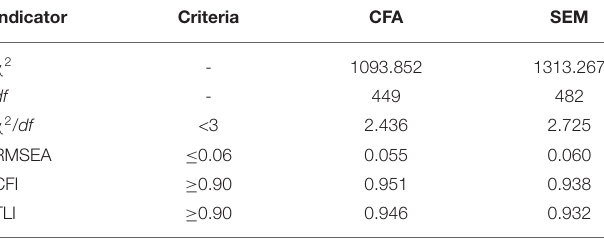
TABLE 4 | Goodness of fit of CFA and